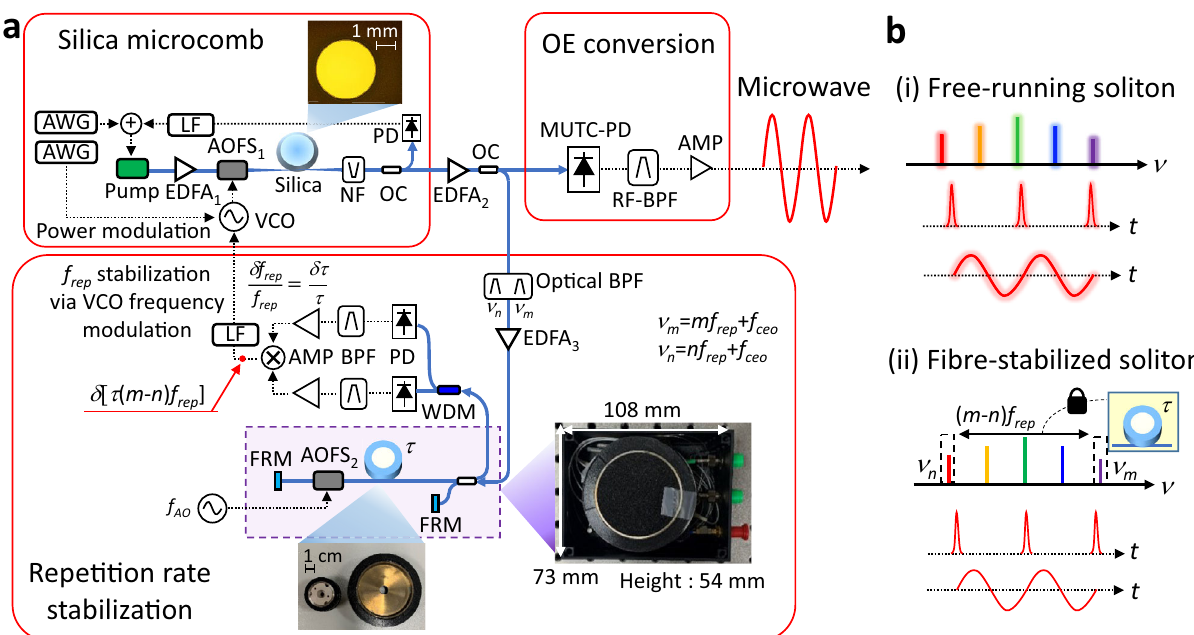
Fig. 1 Ultrastable microwave generation from a silica microcomb stabilised by fi bre photonics. a Schematic of ultrastable microwave generation from a fi bre-stabilised silica microcomb. AWG arbitrary waveform generator, EDFA erbium-doped fi bre ampli fi er, AOFS acousto-optic frequency shifter, VCO voltage-controlled oscillator, NF notch fi lter, OC optical coupler, PD photodiode, LF loop fi lter, MUTC-PD modi fi ed uni-travelling carrier photodiode, RF-BPF 250-MHz-bandwidth radio-frequency bandpass fi lter at 22-GHz, AMP RF ampli fi er, BPF RF-bandpass fi lter at 2f AO , Optical BPF bandpass fi lter for ν n and ν m , f rep repetition rate, f ceo carrier-envelope offset frequency, m and n mode number of ν m and ν n , respectively, FRM Faraday rotating mirror, f AO driving frequency for AOFS 2 , τ time delay induced by the fi bre link. An optical microscope image of a silica microresonator is shown at the top of the fi gure. A photograph of a 200-m-long fi bre link (left) and a 1-km-long fi bre link (right) is displayed at the bottom of the fi gure. A photograph of the entire fi bre- photonic repetition-rate stabiliser (with a case size of 108 mm × 73 mm × 54 mm) is shown on the right side of the fi gure. b Concept of comb-mode frequency noise, timing jitter, microwave phase noise of a free-running microcomb (i) and a fi bre-stabilised microcomb